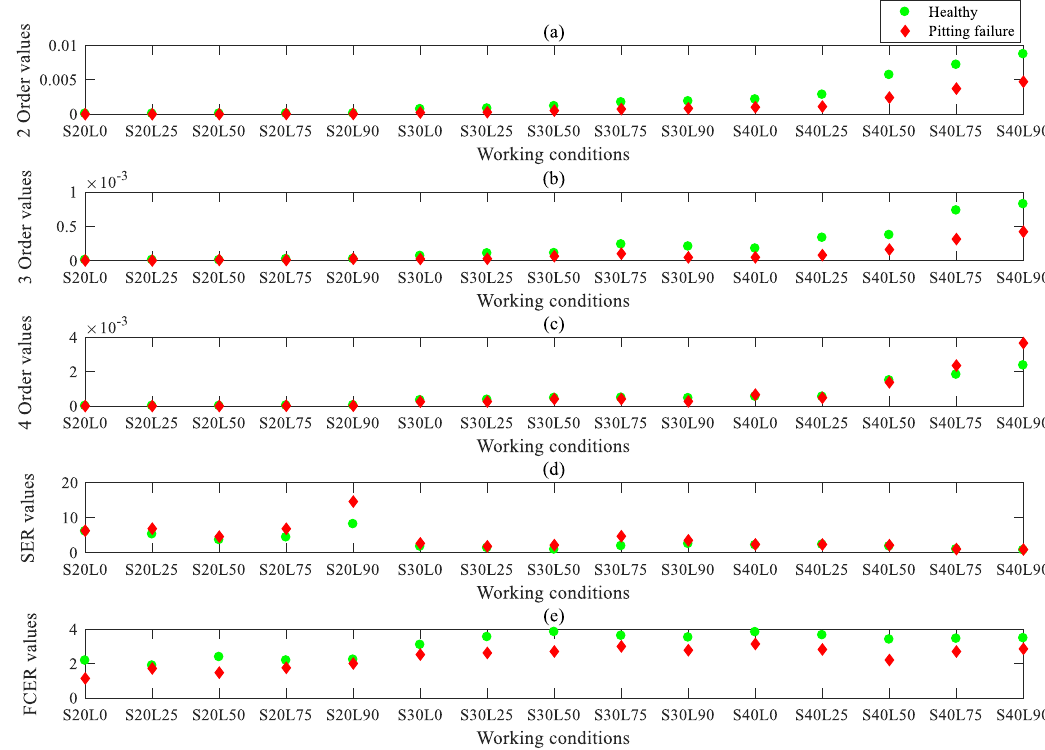
Figure 13. Feature extraction by different methods under different operating conditions: ( a ) Second sun gear order by order bispectrum; ( b ) Third sun gear order by order bispectrum; ( c ) Fourth sun gear order by order bispectrum; ( d ) SER values based on OSA; ( e ) FCER values based on AOBS.